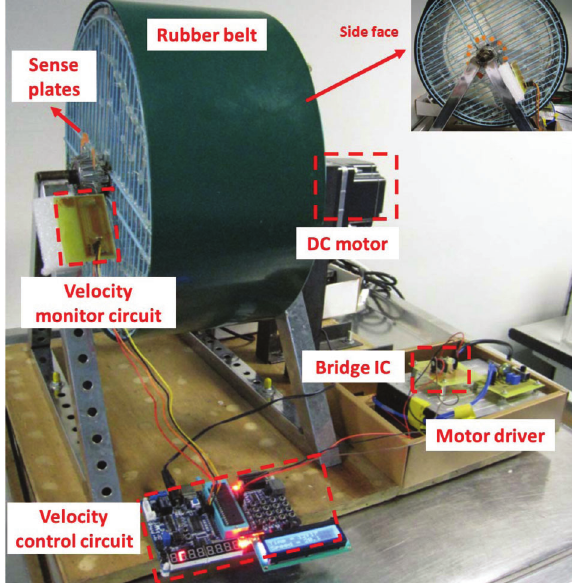
Figure 2. Center axis of the motor and roller are embedded by gears. A hexagonal screw is used to fasten the assembly. Figure 3. Forced non-electric-shock running wheel